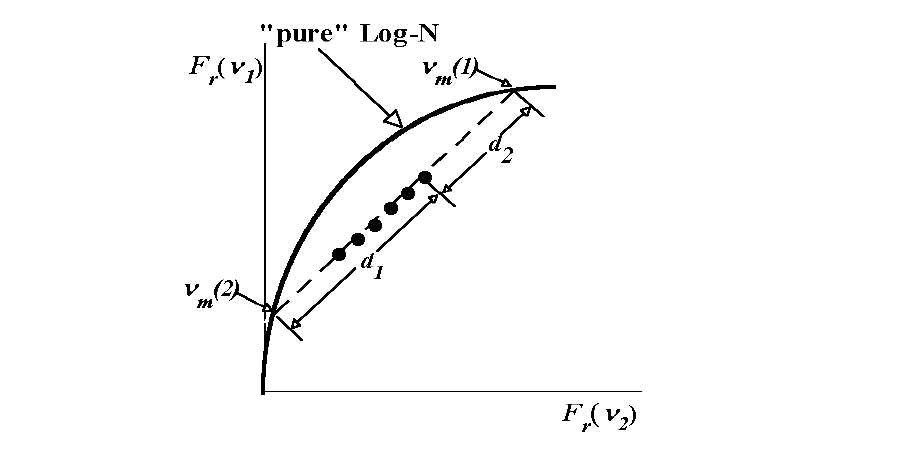
Figure 5. Representation of the fluorescence spectra measured at different concentration of quenchers as points on the quasi-phase plane. The curve “pure” Log-N corresponds to all possible elementary log-normal functions